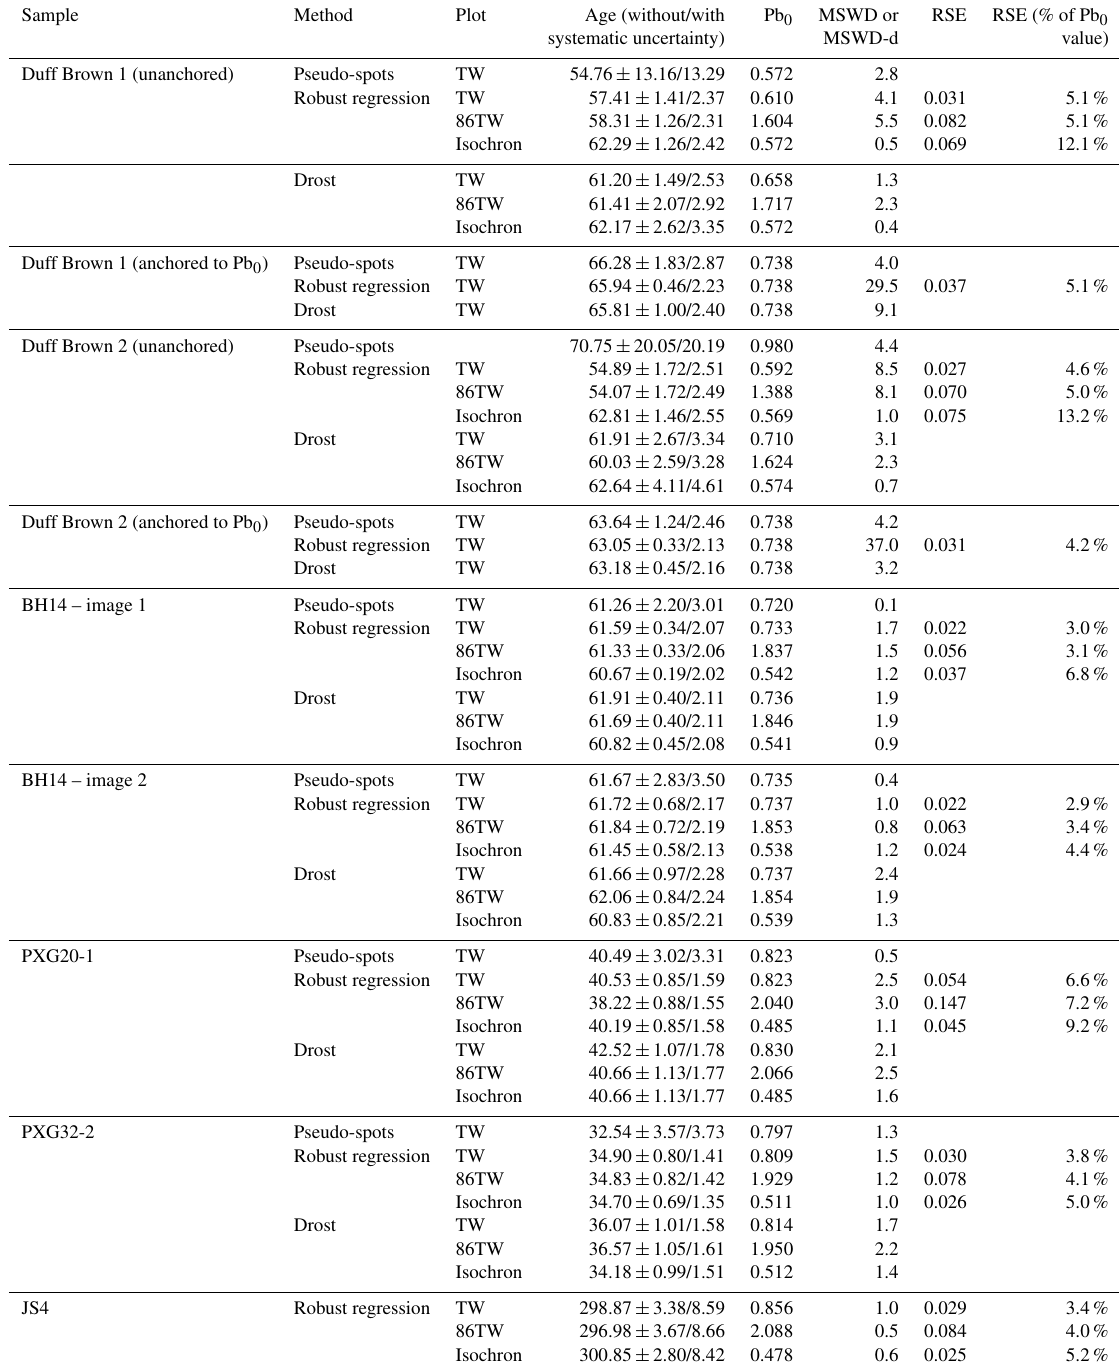
Table 1. Ages calculated from the robust regression, from the pseudo-spots and from the approach of Drost et al. (2018), for all samples.